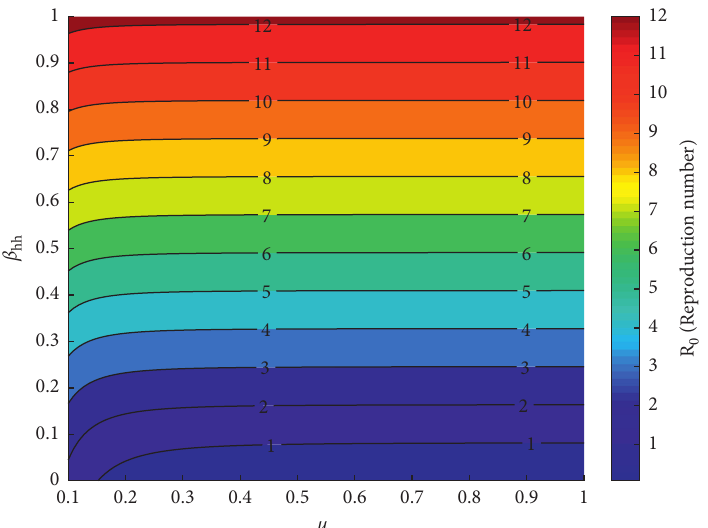
Figure 11: The contour plot of the basic reproduction number as a function of the mortality rate of adult mosquitoes ( μ human transmission rate ( β hh )